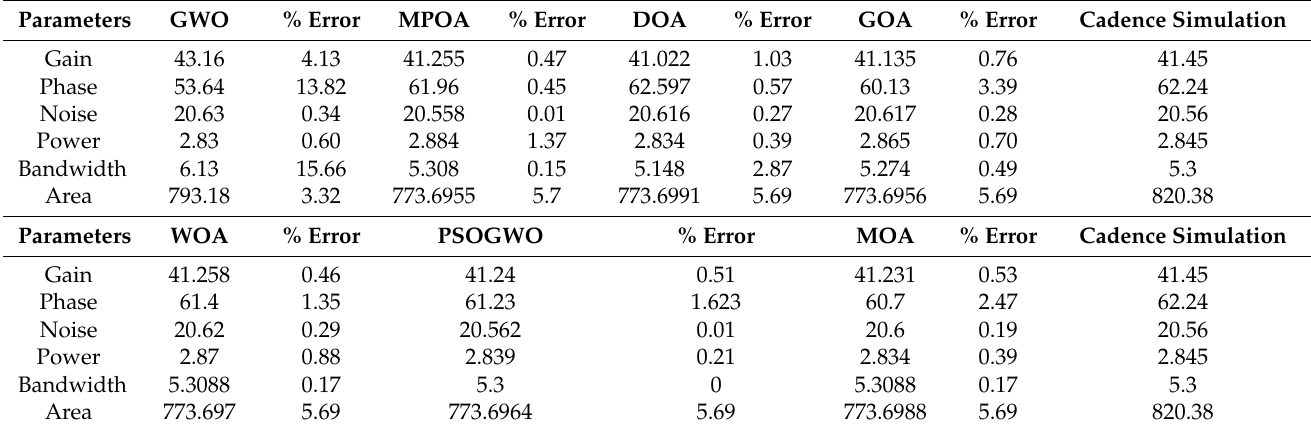
Table 4. Validation with cadence simulations.